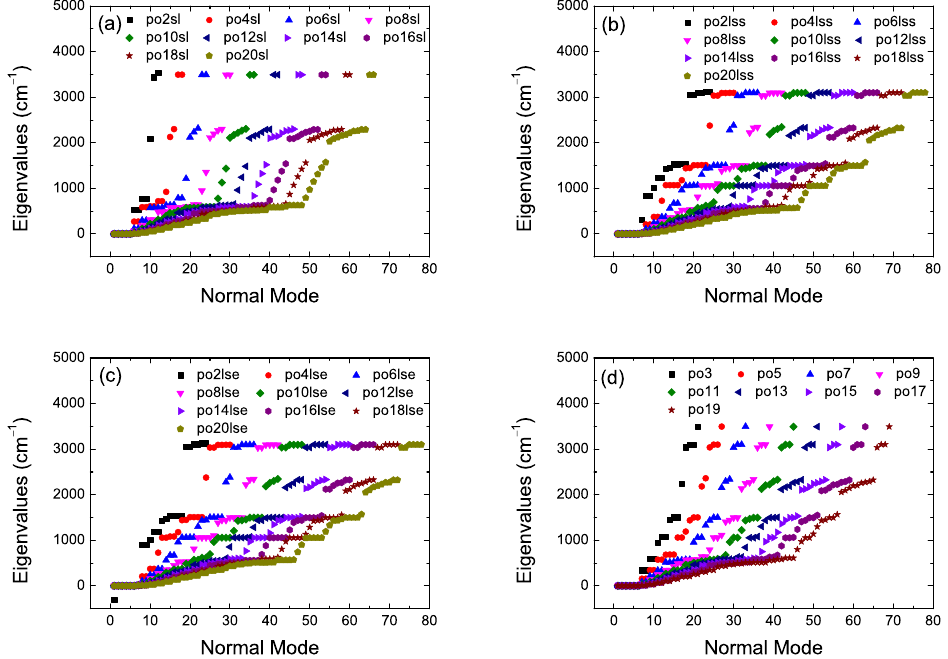
Figure 5. Vibrational analysis of polyynic molecules. B3LYP/6-31G* level of theory, without any constraint on the position of atoms. ( a ) even sl, ( b ) even lss, ( c ) even lse, ( d )